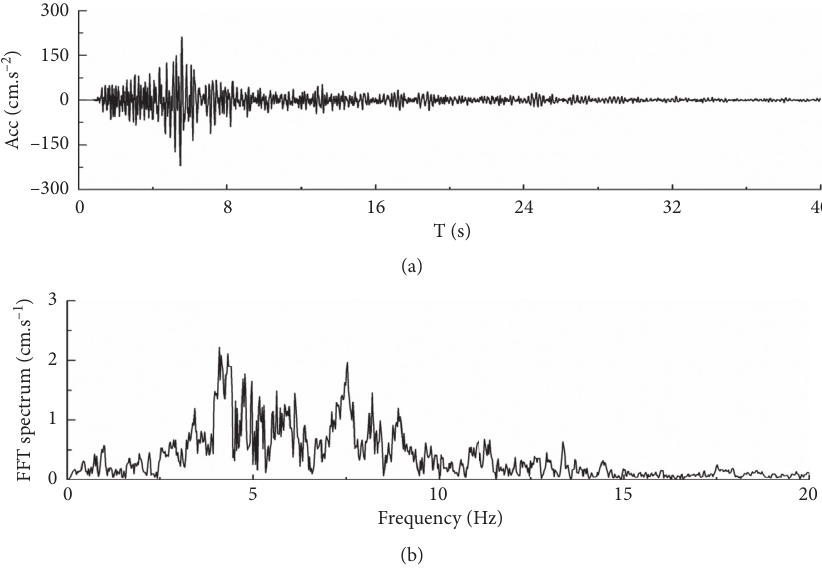
Figure 3: Accelerogram recorded at Minxian seismostation during the Minxian–Zhangxian